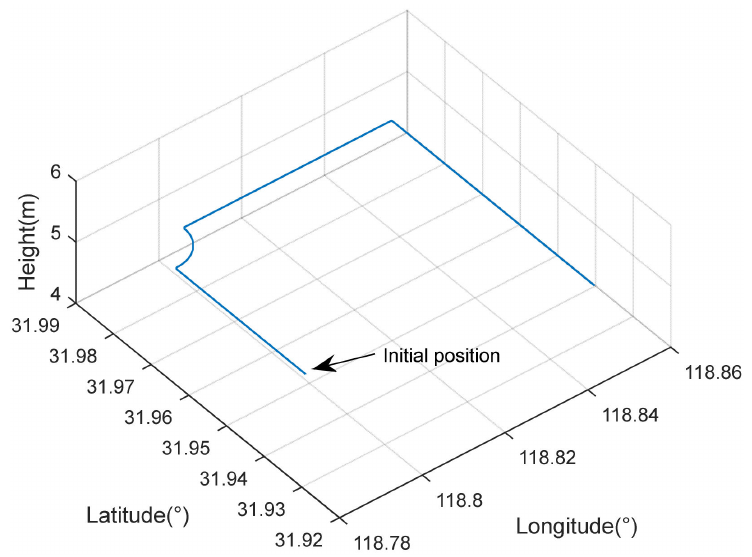
Figure 4. The path of vehicles.